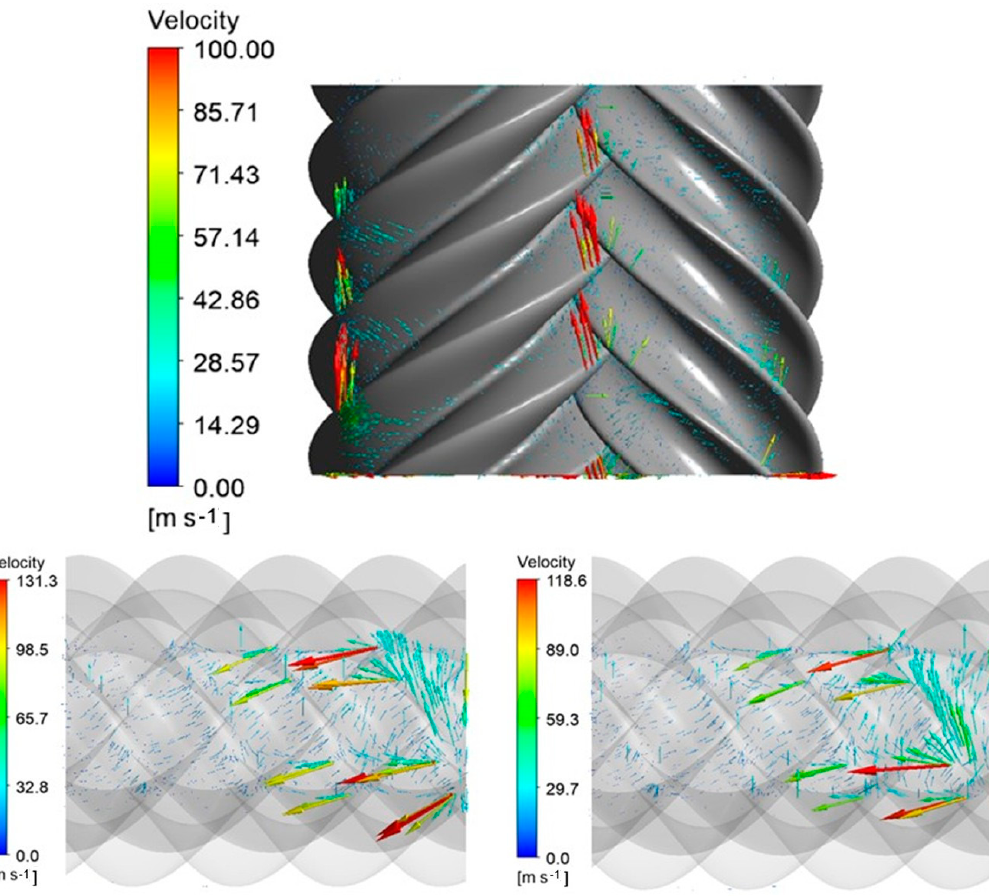
Figure 9. The leakage fl ows at the rotors.